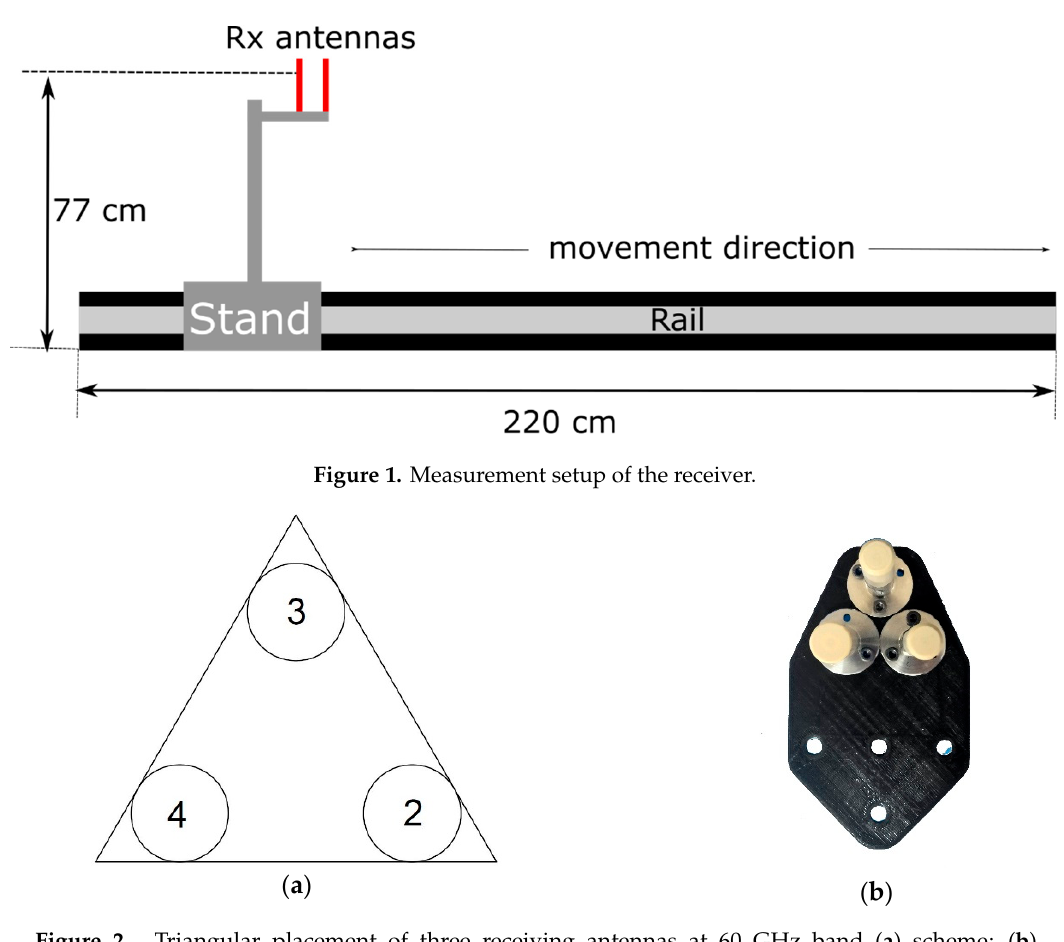
Figure 2. Triangular placement of three receiving antennas at 60 GHz band ( a ) scheme; ( b ) final realization.